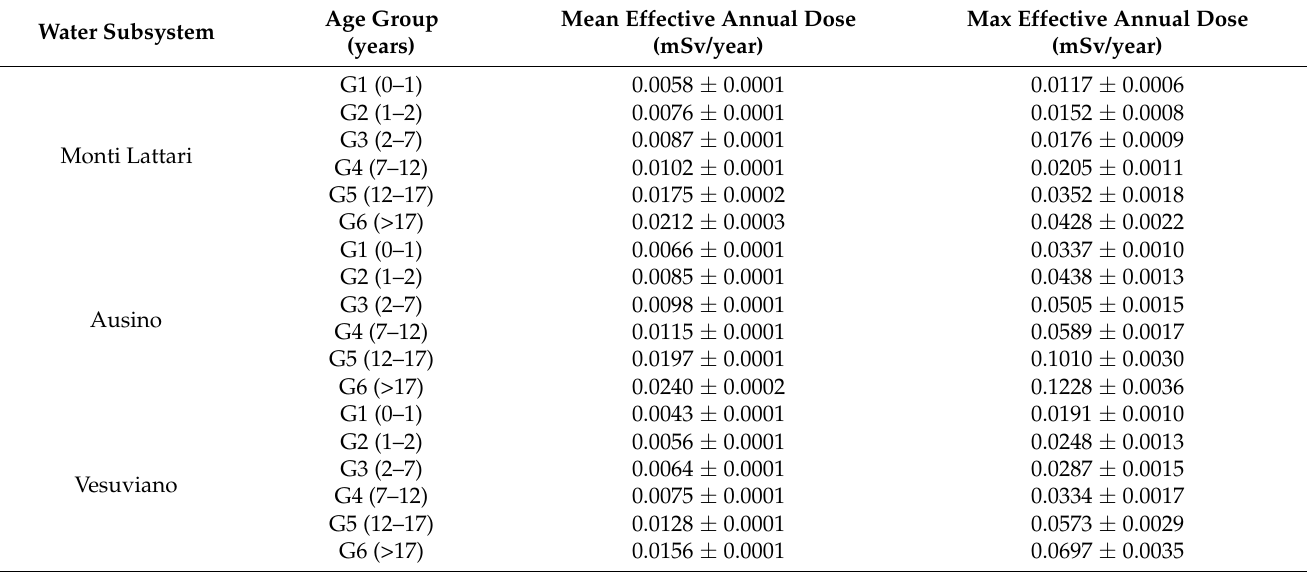
Table 10. Mean and maximum effective annual dose calculated for each water subsystem. The calculated doses are divided into three different categories (infants, children, and adults) distributed through six groups